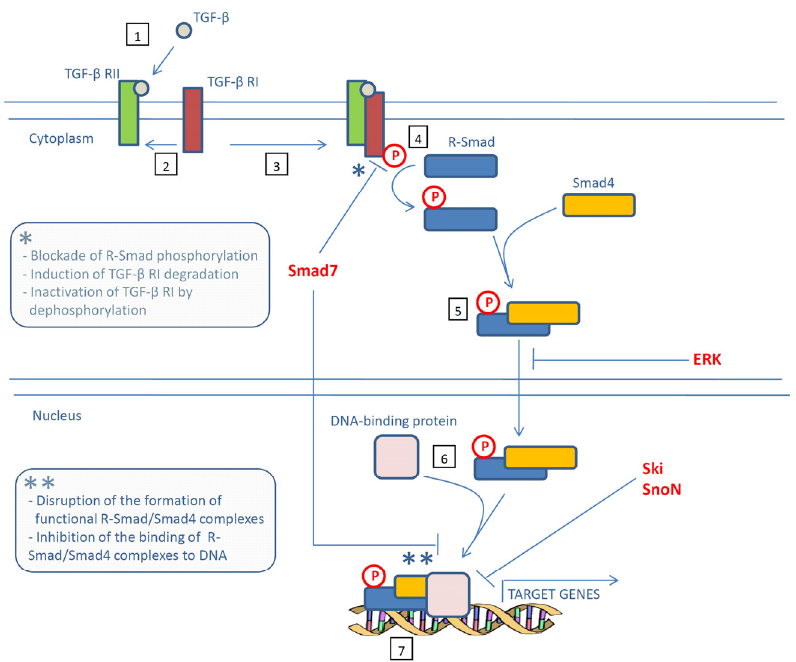
Figure 1. Schematic overview of the transforming growth factor (TGF)- β signaling pathway. Binding of TGF- β to its type II receptor (TGF- β RII) ( 1 ) attracts the TGF- β type I receptor (TGF- β RI) ( 2 ) and leads to formation of a receptor complex ( 3 ) and phosphorylation of TGF- β RI ( 4 ). Thus activated, TGF- β RI in turn phosphorylates a receptor-activated Smad (R-Smad) ( 4 ), allowing this protein to associate with Smad4 and move into the nucleus ( 5 ). Once in the nucleus, this Smad complex associates with DNA-binding proteins ( 6 ) to activate the transcription of specific target genes ( 7 ). Negative regulators of this signaling pathway are indicated in red. * and ** indicate mechanisms by which Smad7 antagonizes TGF- β signaling in the cytoplasm and in the nucleus